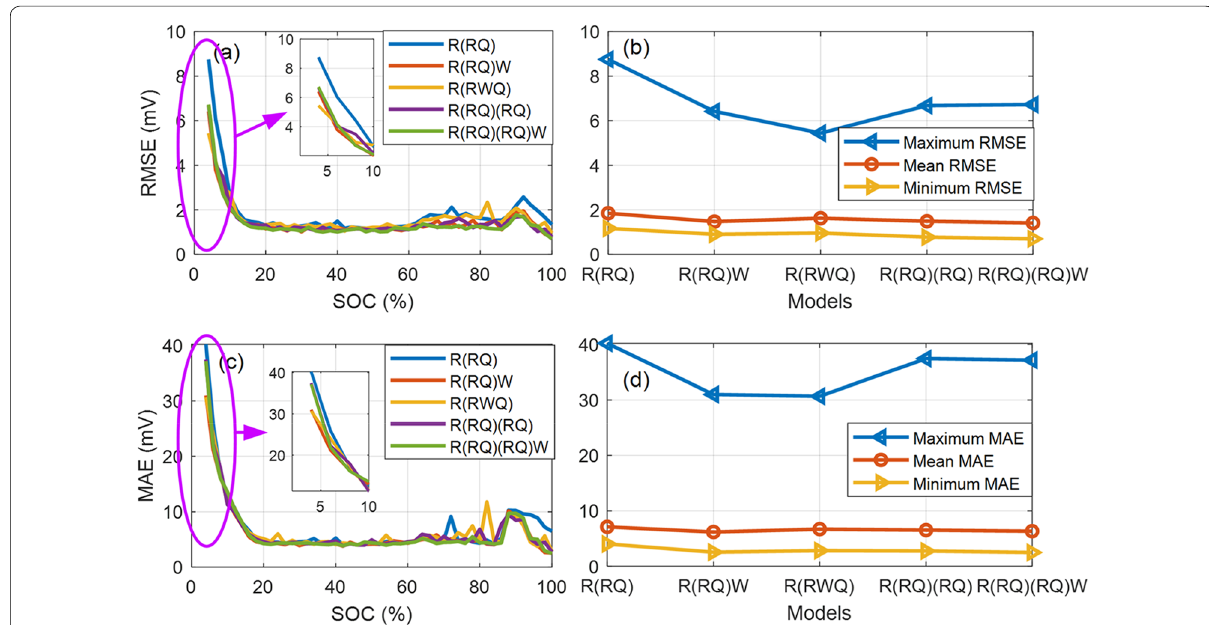
Figure 5 Identification error of 5 FOMs: a RMSE over the SOC range of [4%, 100%], b Maximum, mean and minimum RMSE, c The MAE over the SOC range of [4%, 100%], d Maximum, mean and minimum